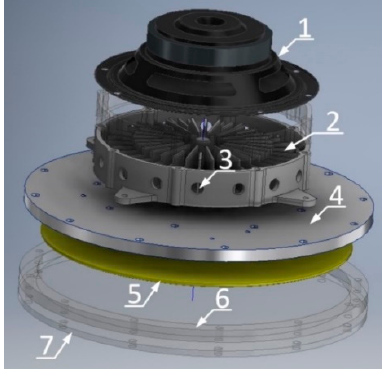
Figure 1. Exploded model of the LED lamp: 1—loudspeaker, 2—heat sink inside the cavity, 3—orifices, 4—heat spreading plate, 5—PCB with LEDs, 6—distance ring, 7—transparent PMMA plate. A total of 320 mid-power 3030 STW8C12C-E0 SMD LEDs manufactured by Seoul Semiconductor were soldered onto the PCB made of FR4 laminate (Figure 2a). The external diameter of the PCB was 250 mm. The model STW8C12C-E0 is a white LED (4000 K,